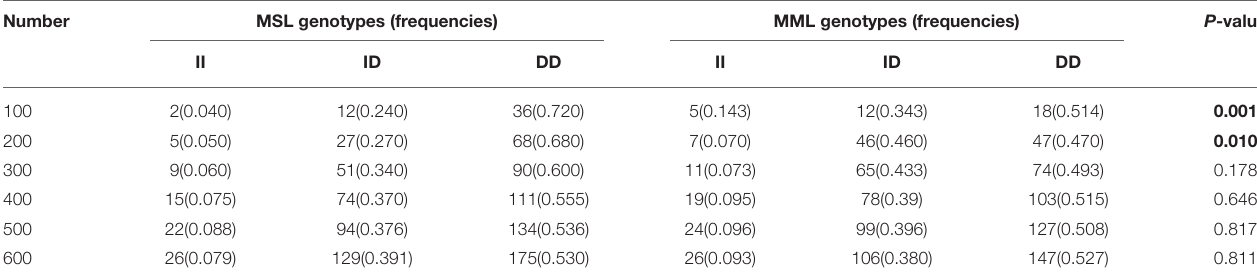
TABLE 6 | The 5 bp locus genotype distribution between mothers of single lamb and multi-lamb litters in Shaanbei white cashmere goats.